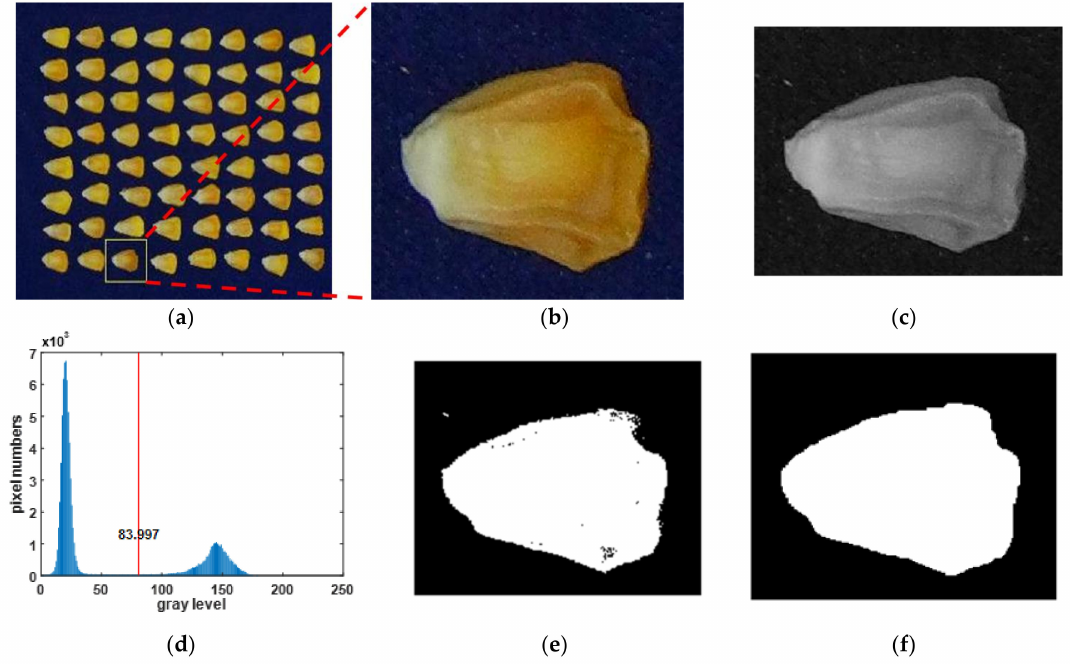
Figure 4. Foreground region segmentation of sweet corn seed: ( a ) image of sweet corn seeds, ( b ) magnification of a single seed, ( c ) the grayscale image of one seed, ( d ) the grayscale histogram, ( e ) binary image of one seed, ( f ) the image obtained after morphological